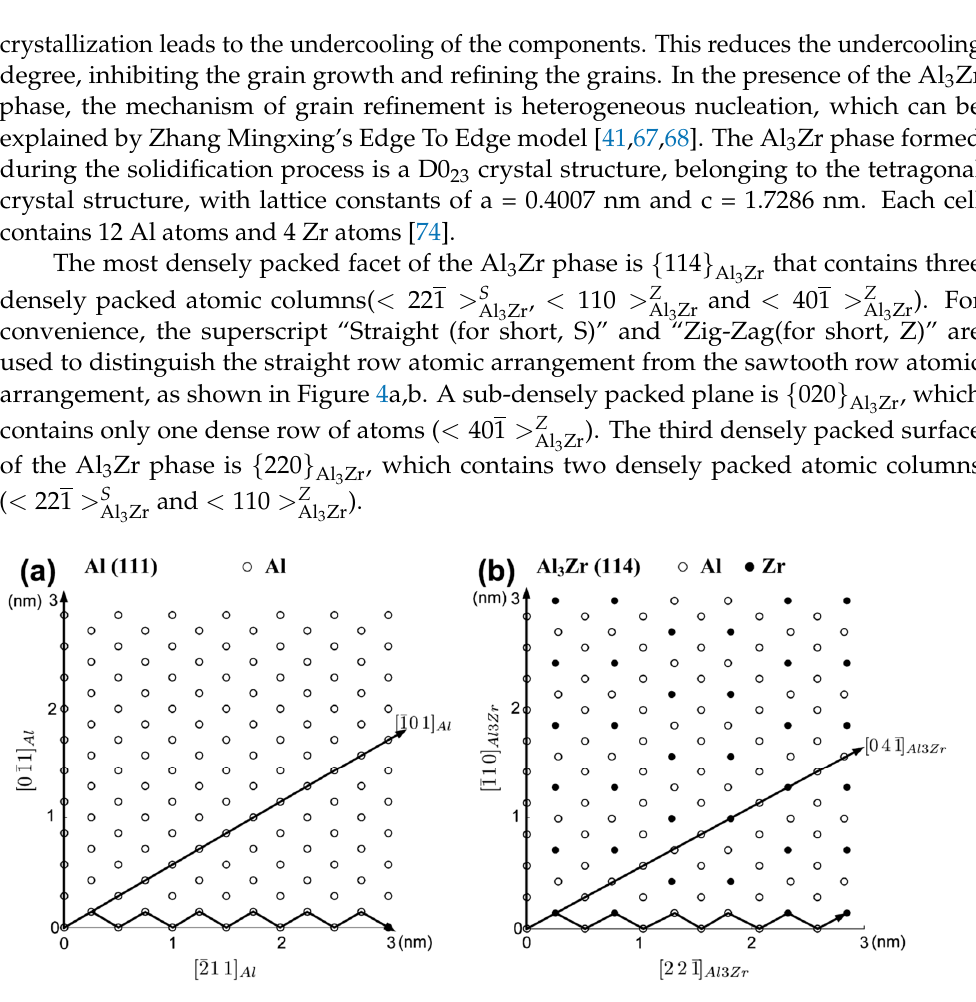
Table 2. Result of calculations [28].